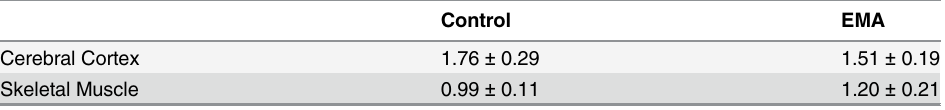
Table 2. Effect of acute administration of ethylmalonic acid (EMA) on respiratory chain complex I-III activity in cerebral cortex and skeletal muscle of rats.